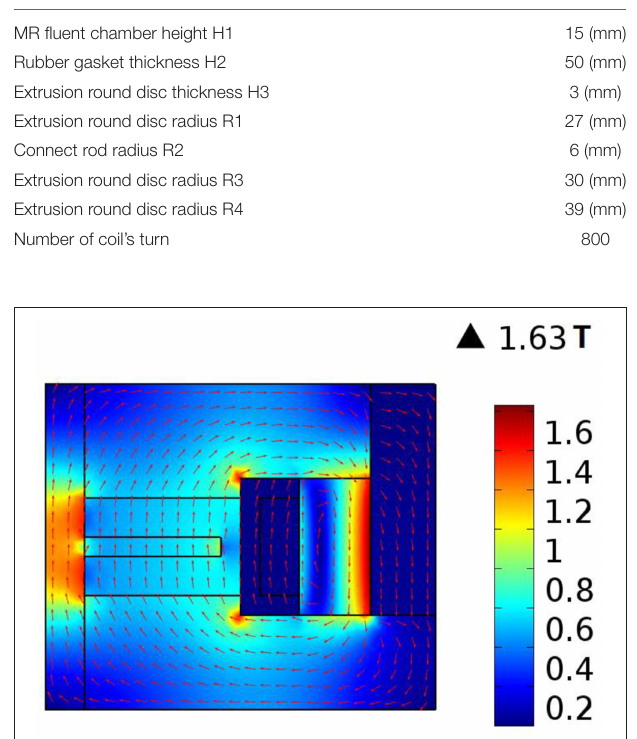
FIGURE 3 | Result of the magnetic circuit analysis.